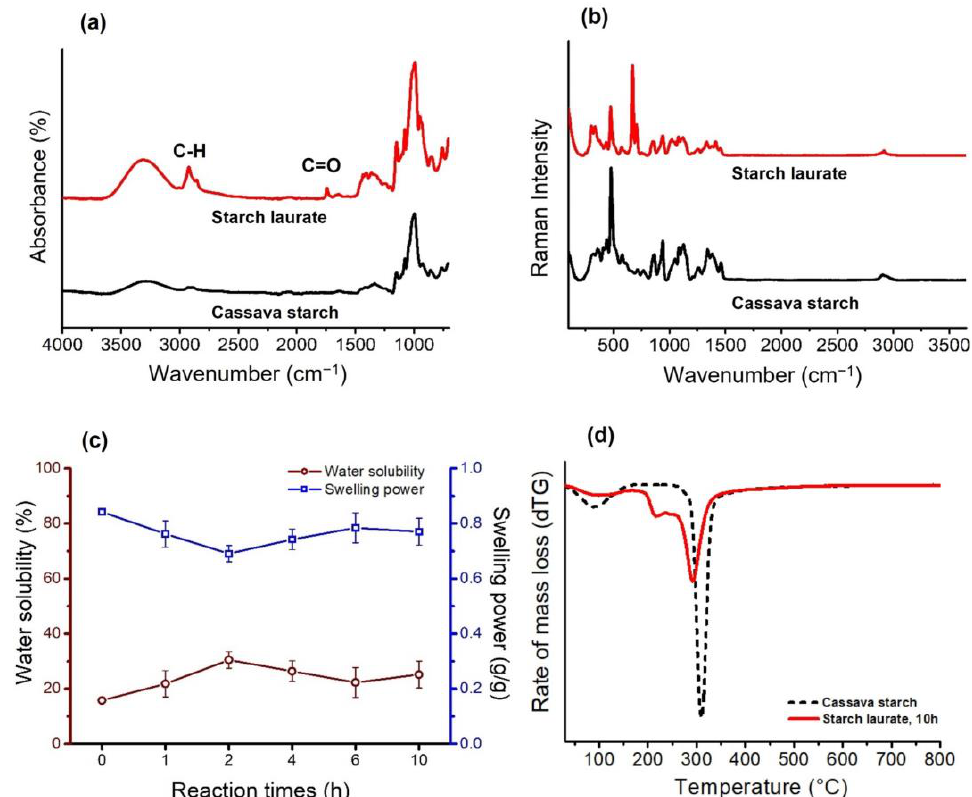
Figure 4. ( a ) FTIR spectra of cassava starch and starch laurate (10 h). ( b ) Raman spectra of cassava starch and starch laurate (10 h). ( c ) Water solubility (%) in red line and Swelling power (g/g) in blue line of native cassava starch (0 h) and starch laurate with different reaction times. ( d ) Derivative thermal gravity (dTG) thermogram cassava starch and starch laurate (10 h).